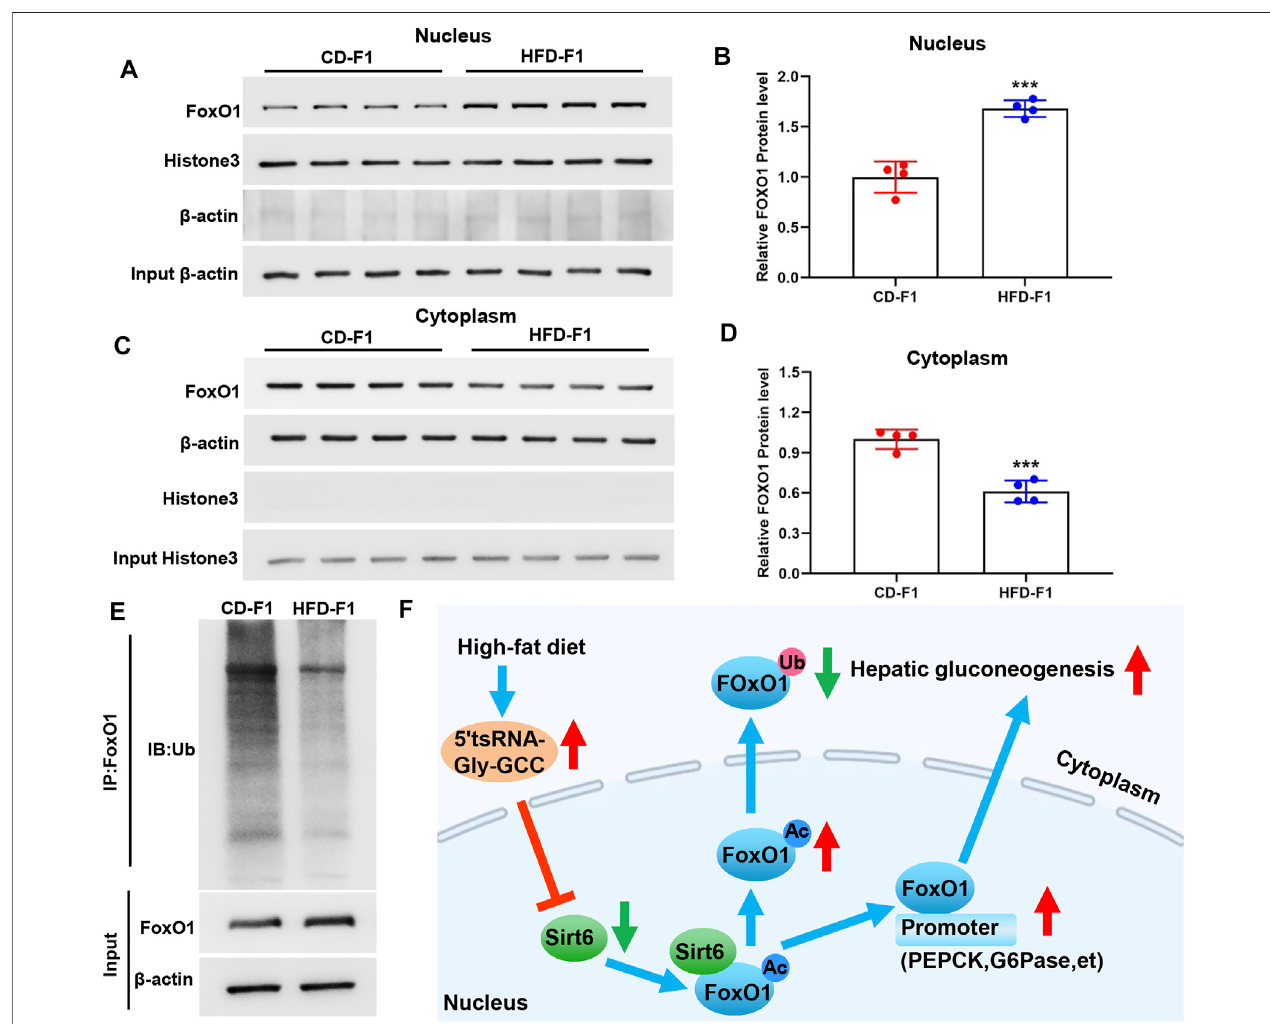
FIGURE6| FoxO1activationcausedbyreducedFoxO1nuclearexclusionandubiquitinationdegradationinHFD-F1liver. (A – D) CytoplasmicandnuclearFoxO1in liver tissue from HFD-F1 mice and CD-F1 mice was examined by Western blotting. Cytoplasmic protein β -actin and nuclear protein histone3 served as controls. ( n = 4). (E) Liver tissue from HFD-F1 mice and CD-F1 mice were collected for the immunoprecipitation with FoxO1 antibody. FoxO1 and ubiquitinated FoxO1 protein were examined by Western blotting. (F) Schematic diagram of the mechanism by which 5 ′ tsRNA-Gly-GCC regulates the Sirt6-FoxO1 pathway involved in enhanced gluconeogenesis in the offspring as a result of the paternal high-fat diet. *** p < 0.001.